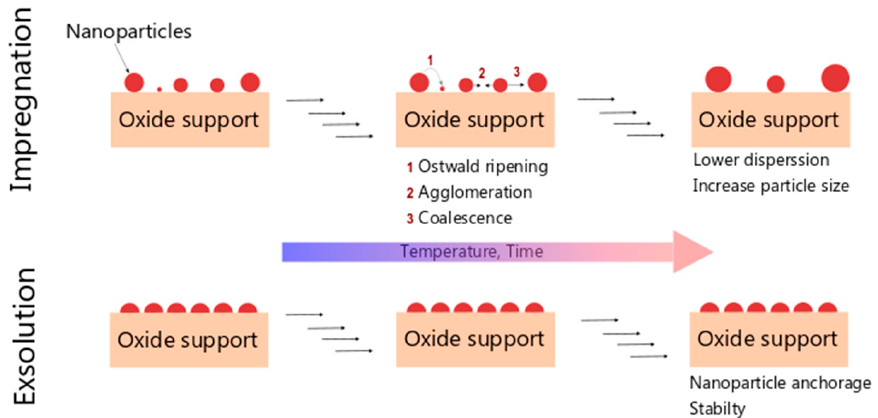
Figure 1. Schematic depicting the morphological evolution differences of dispersed metallic nanoparticles on oxide supports when prepared by impregnation or exsolution methods.